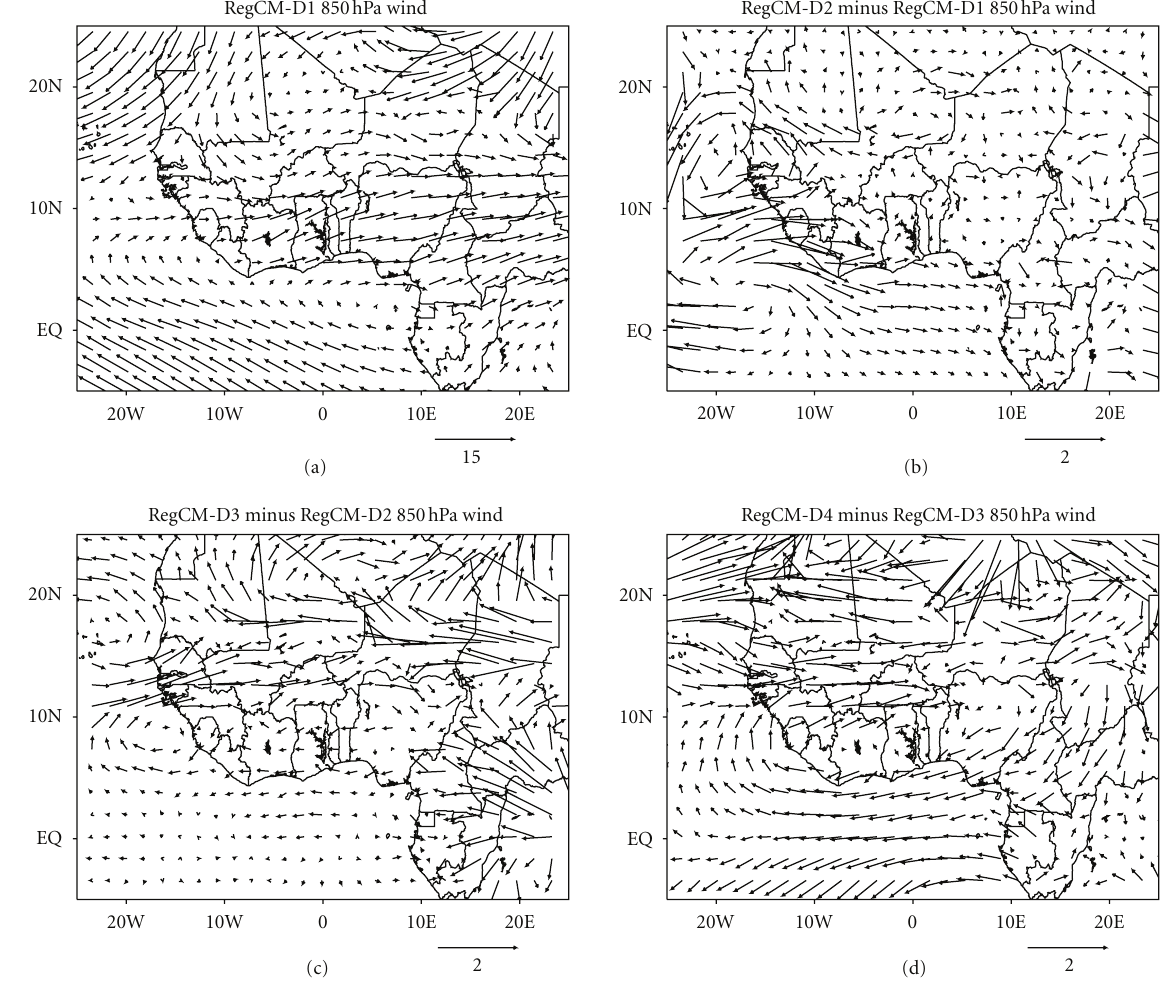
Figure 7: Mean JJA low-level (850hPa) monsoon flow averaged for the period 2001–2005 for (a) RegCM-D1, (b) the di ff erences between RegCM-D2 and RegCM-D1, (c) the di ff erences between RegCM-D3 and RegCM-D2, and (d) the di ff erences between RegCM-D4 and RegCM-D3. Units are expressed in